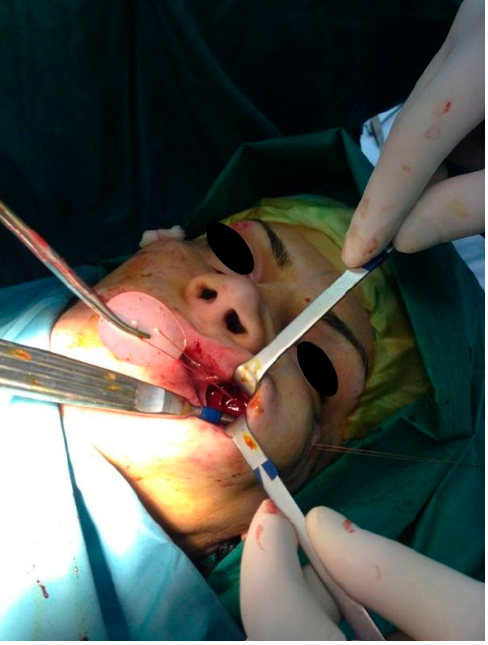
Figure 2. Once the suture has passed through the soft tissue and the implant, the two sutures ends are pulled by the assistant surgeon, and the first surgeon carefully places the implant into the previously harvested